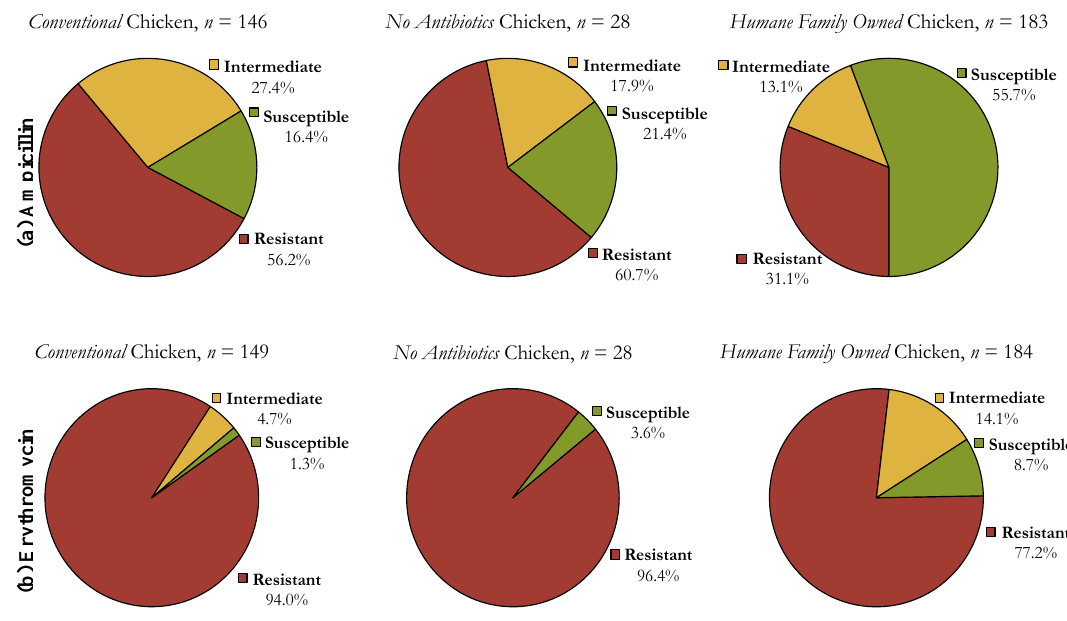
Figure 1. Pie charts showing the percentage of resistant, intermediate, and susceptible isolates for each of the three production categories of chicken— Conventional , No Antibiotics , and Humane Family Owned . ( a , b ) demonstrate resistance and susceptibility to ampicillin and erythromycin, respectively.